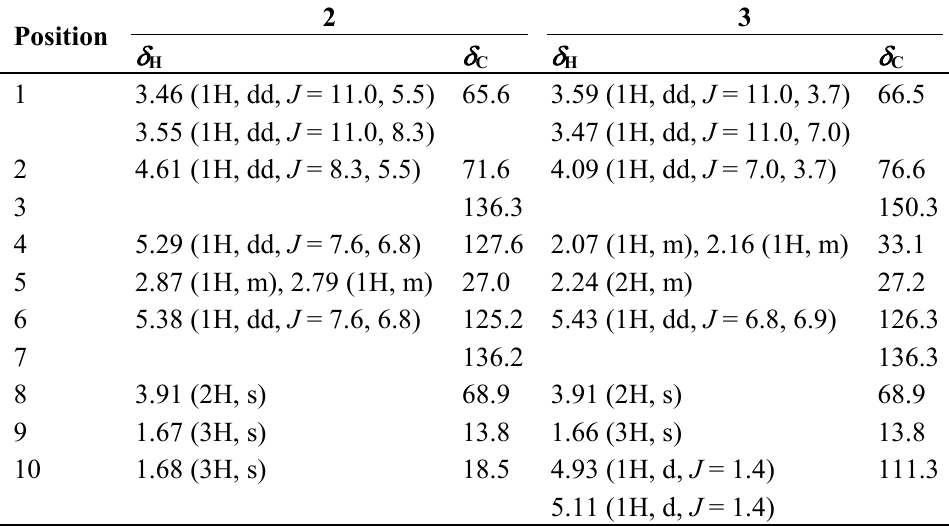
OD, J in Hertz and  in ppm). 3